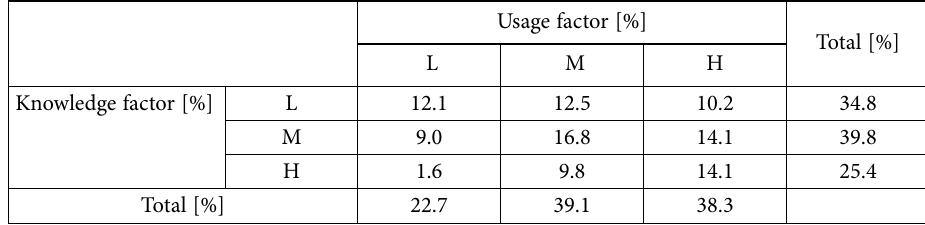
Table 6. Respondents’ distribution according to knowledge and usage